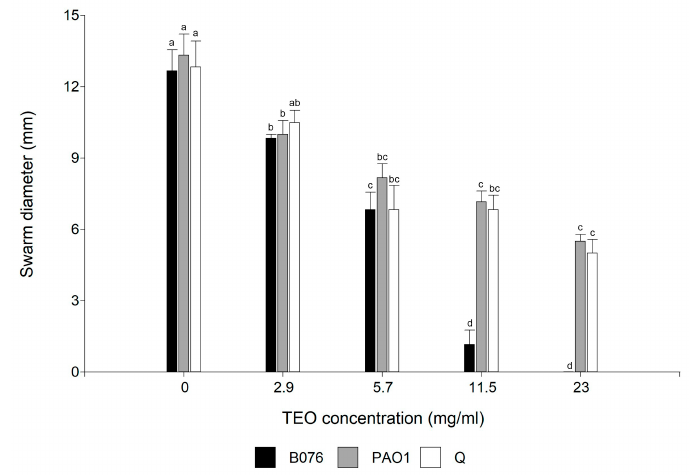
Figure 9. The effect of different concentrations of TEO on swarming motility (0.5% agar) in P. syringae Q, P. savastanoi pv. glycinea BO76, and in P. aeruginosa PAO1, observed after 48 h of incubation. The results are expressed as the mean ± standard error (SEM) of the swarm diameter in millimetres (mm). Means with different letters indicate statistically significant differences ( p < 0.05). Lowercase letters compare the control (0 mg/mL) and the strains treated with different concentrations of TEO.